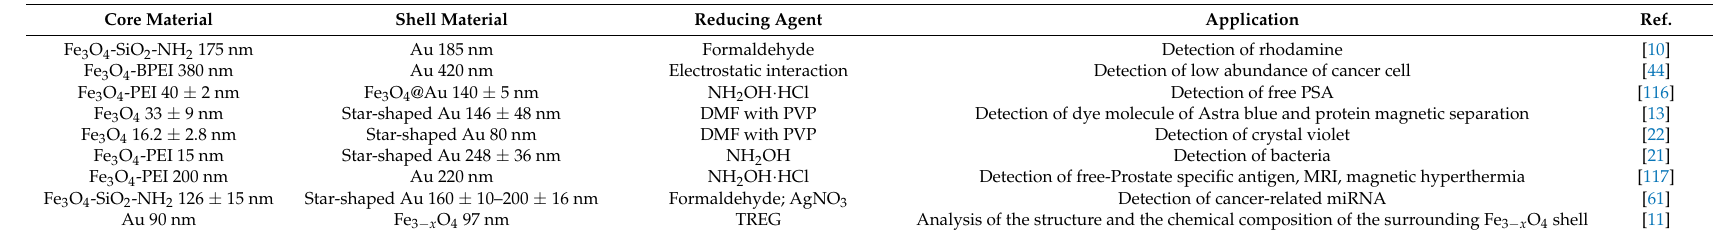
Table 1. FANSs and AFNSs for SERS